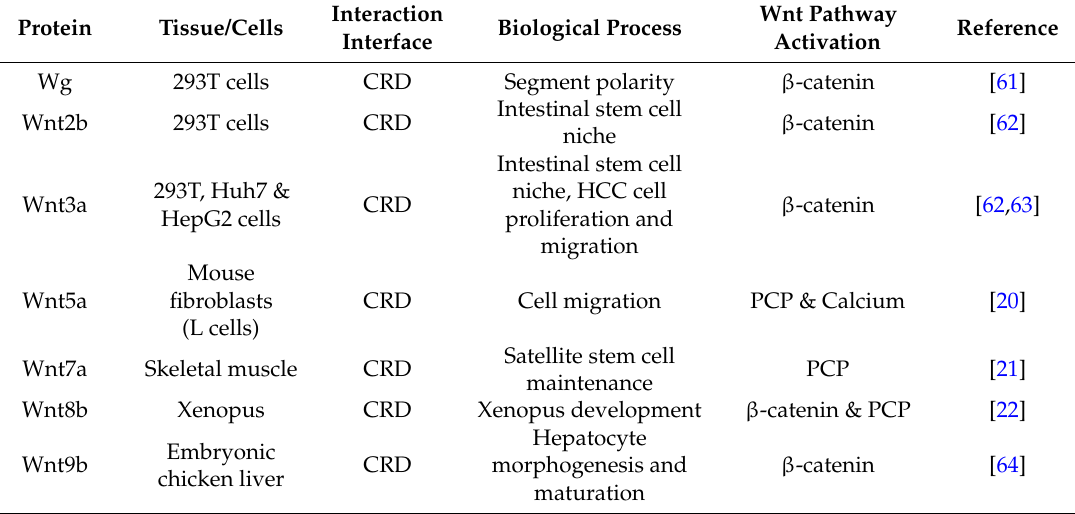
Table 1. List of proteins which are shown to associate with